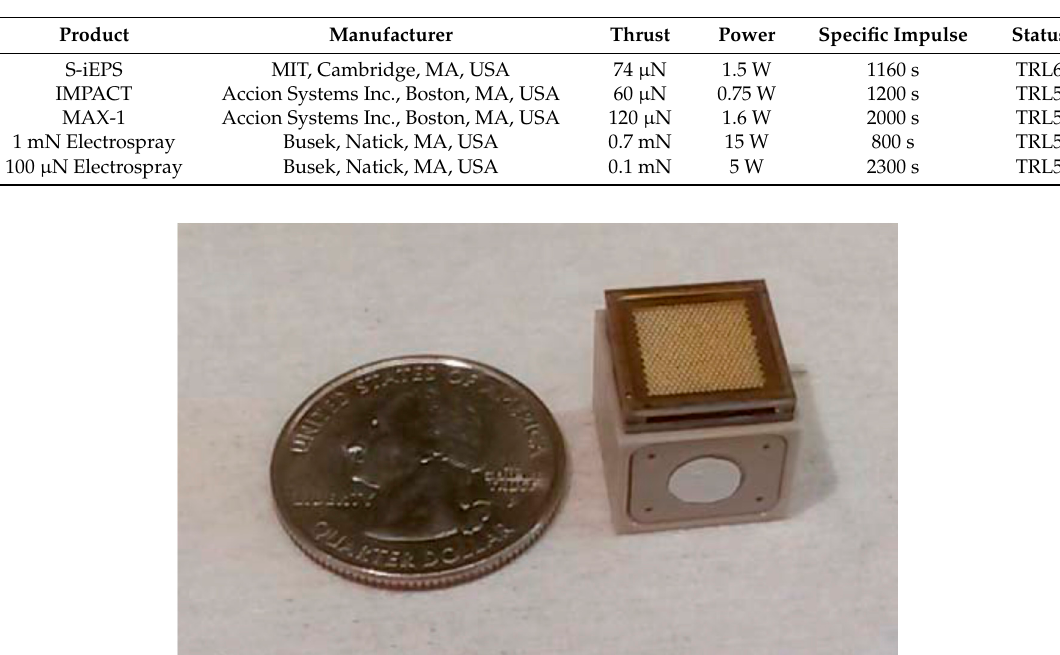
Table 11. Electrospray Thruster Performance data [23].